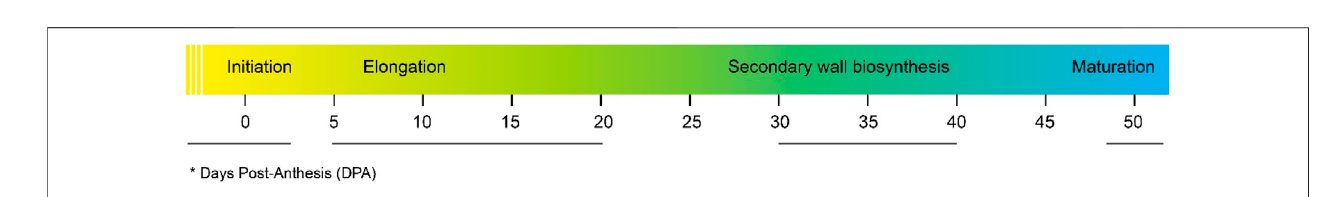
FIGURE 2 | Cotton fi ber development stages at various